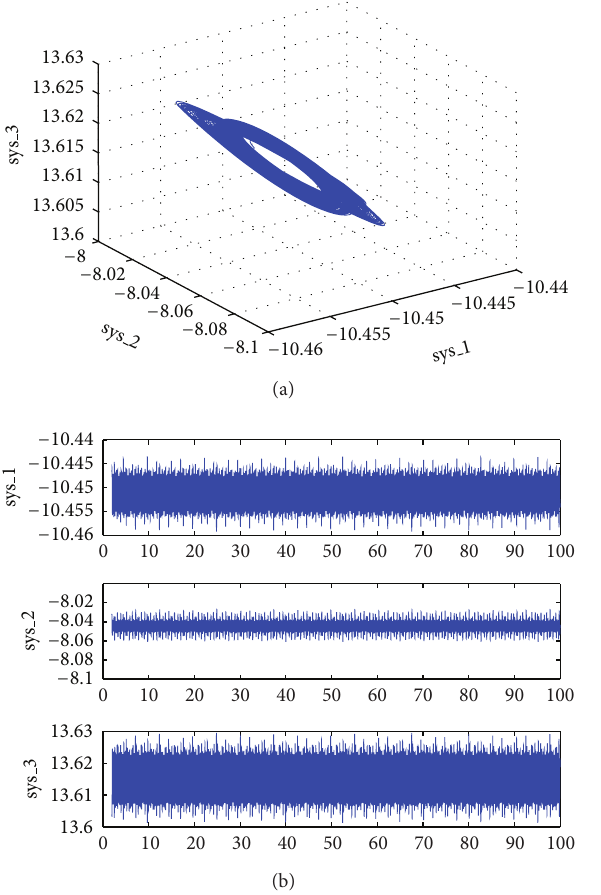
Figure 3: The Lorentz-R¨ossler combining system with initial value = (1, 0.1, 1) . 𝑋 0